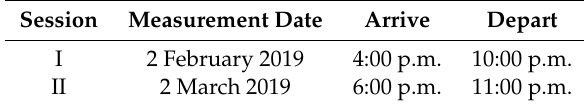
Table 1. Terminal 3 air quality measurement schedule.